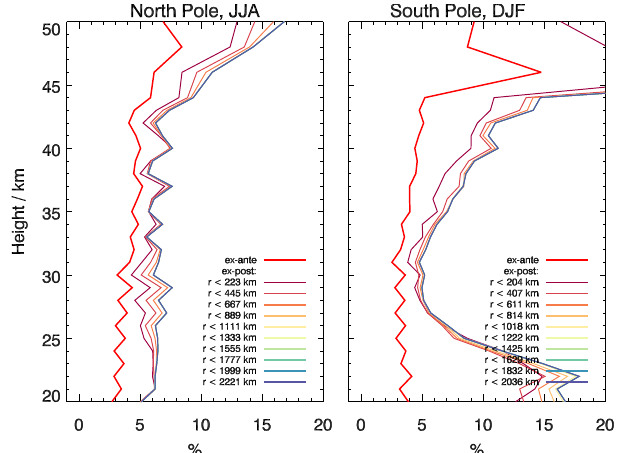
Figure 8. Structure functions of MIPAS IMK processor in two re- gions with low atmospheric variability: the North Pole in June- July-August (JJA, left column) and the South Pole in December- January-February (DJF, right column). The analysis was run on 430 pairs within 220km, 7500 pairs within 880km, going up to 12400 pairs within more than 2000km. The colored lines correspond to √ S diff / 2 for converging distance r between the air parcels, and the red line shows σ random . In the terminology of von Clarmann (2006), √ S diff / 2 is the ex post error and σ random is the ex ante estimate of the error.